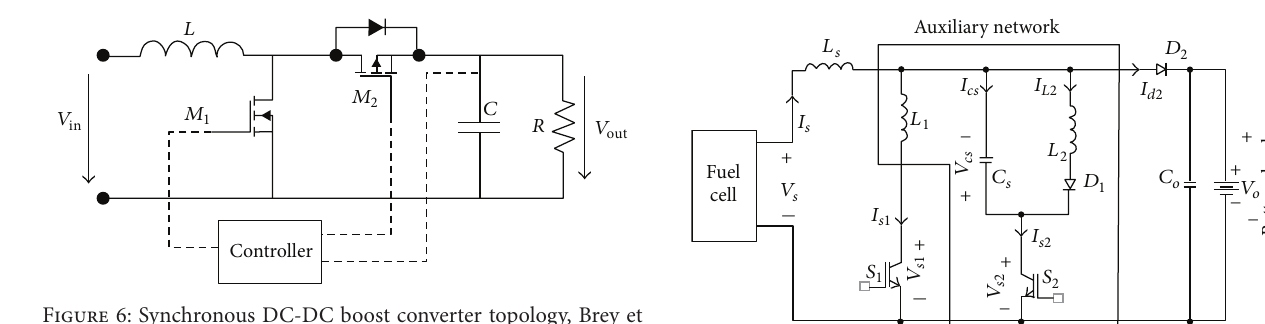
Figure 6: Synchronous DC-DC boost converter topology, Brey et al. [6].